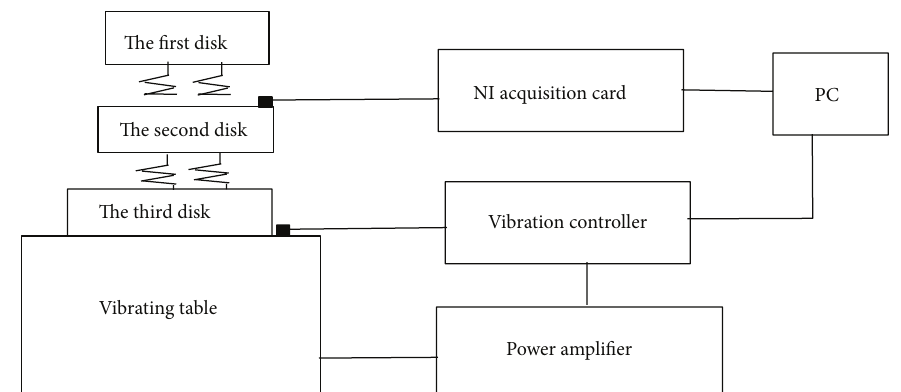
Figure 23: Experimental schematic diagram of looseness fault.